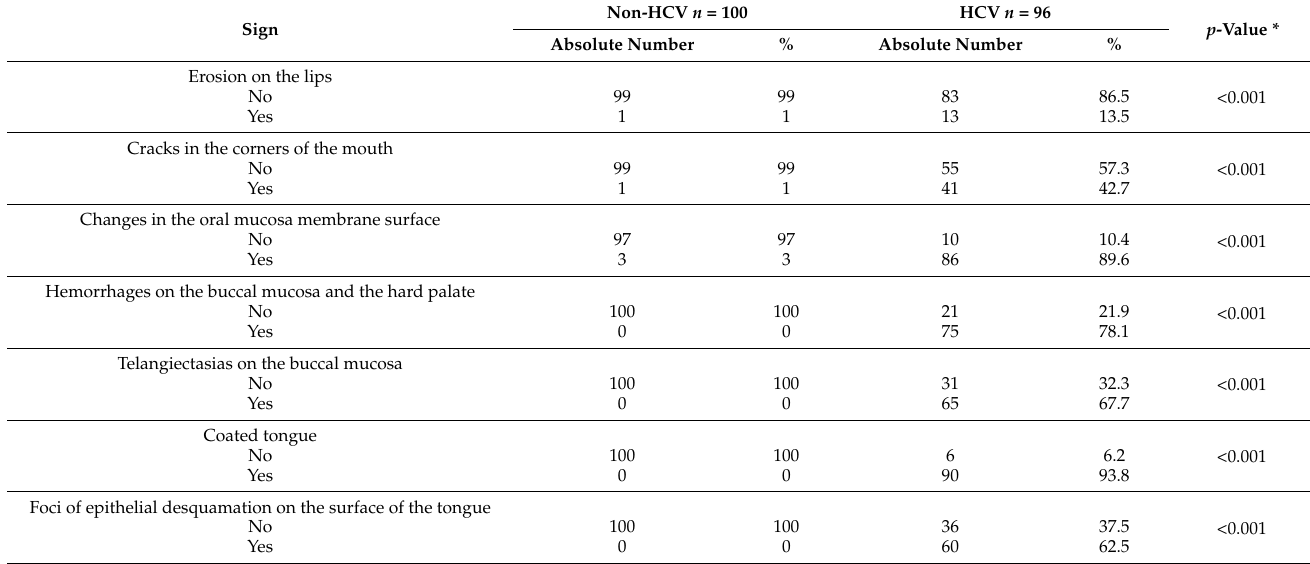
Table 1. Clinical examination data of the oral mucosa in patients with HCV and in the non- HCV